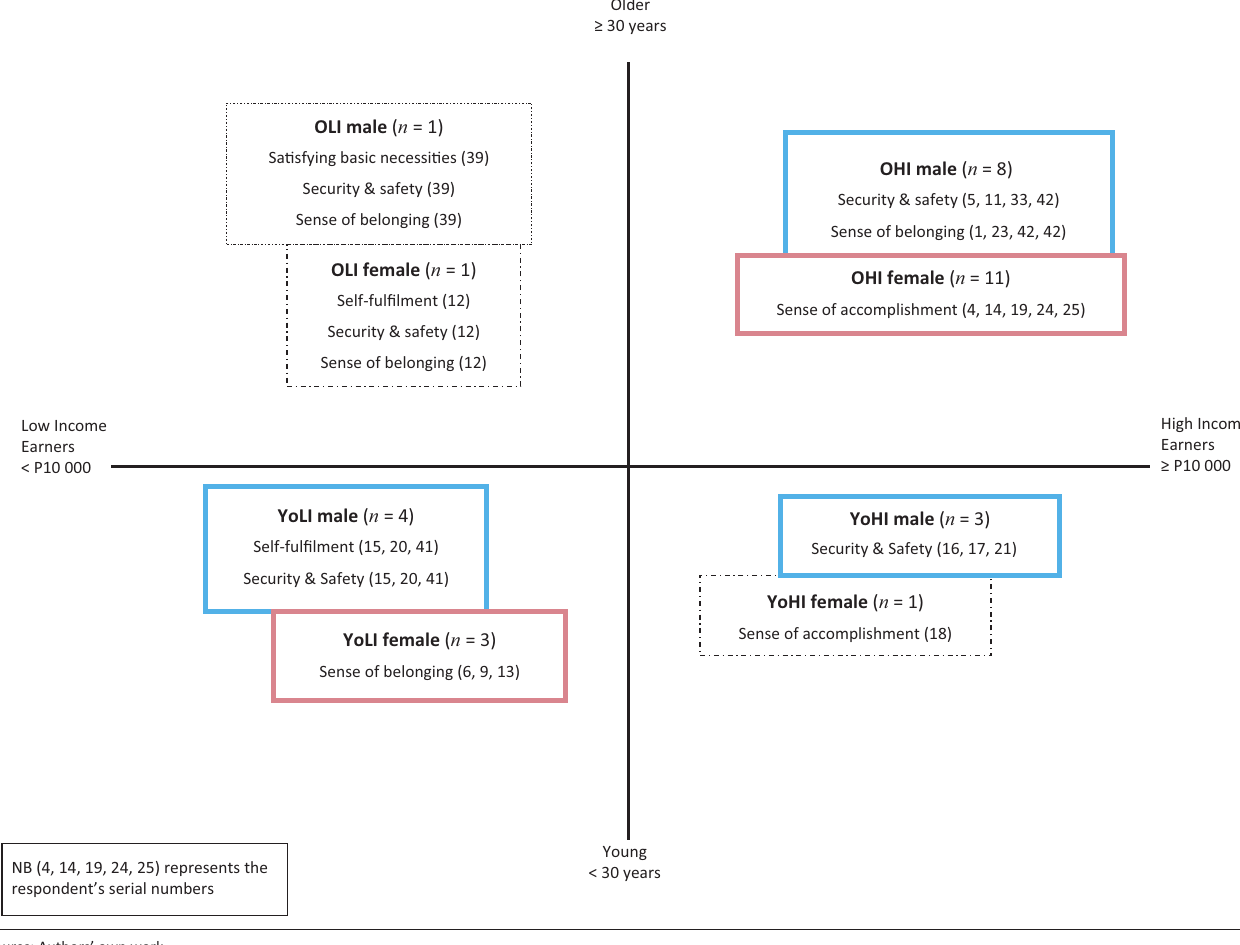
FIGURE 1: Personal values of